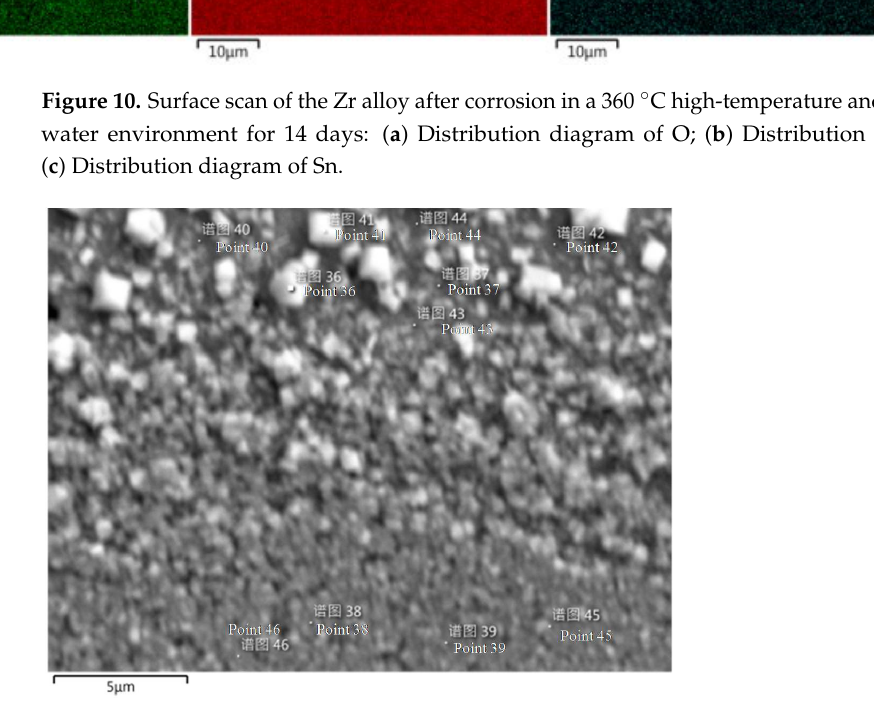
Figure 11. Spot scan of the (FeNi) 67 Cr 15 Mn 10 Al 5 Ti 3 alloy after corrosion in a 360 ◦ C high-temperature and high-pressure water environment for 14 days. Table 3. Spot scan composition of the (FeNi) 67 Cr 15 Mn 10 Al 5 Ti 3 alloy after corrosion in a 360 ◦ C high-temperature and high-pressure water environment for 14 days.